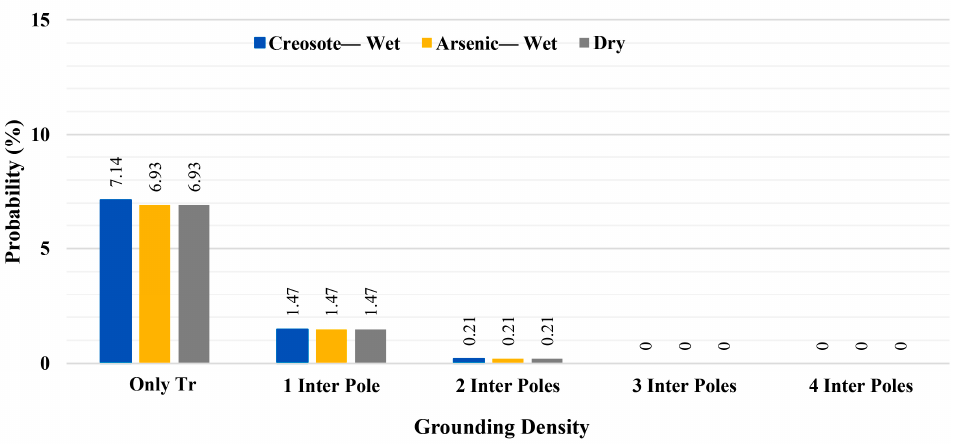
Figure 16. Comparison among the probabilities of transformers experiencing overvoltage stress above 125 kV under different grounding densities, Case 2.